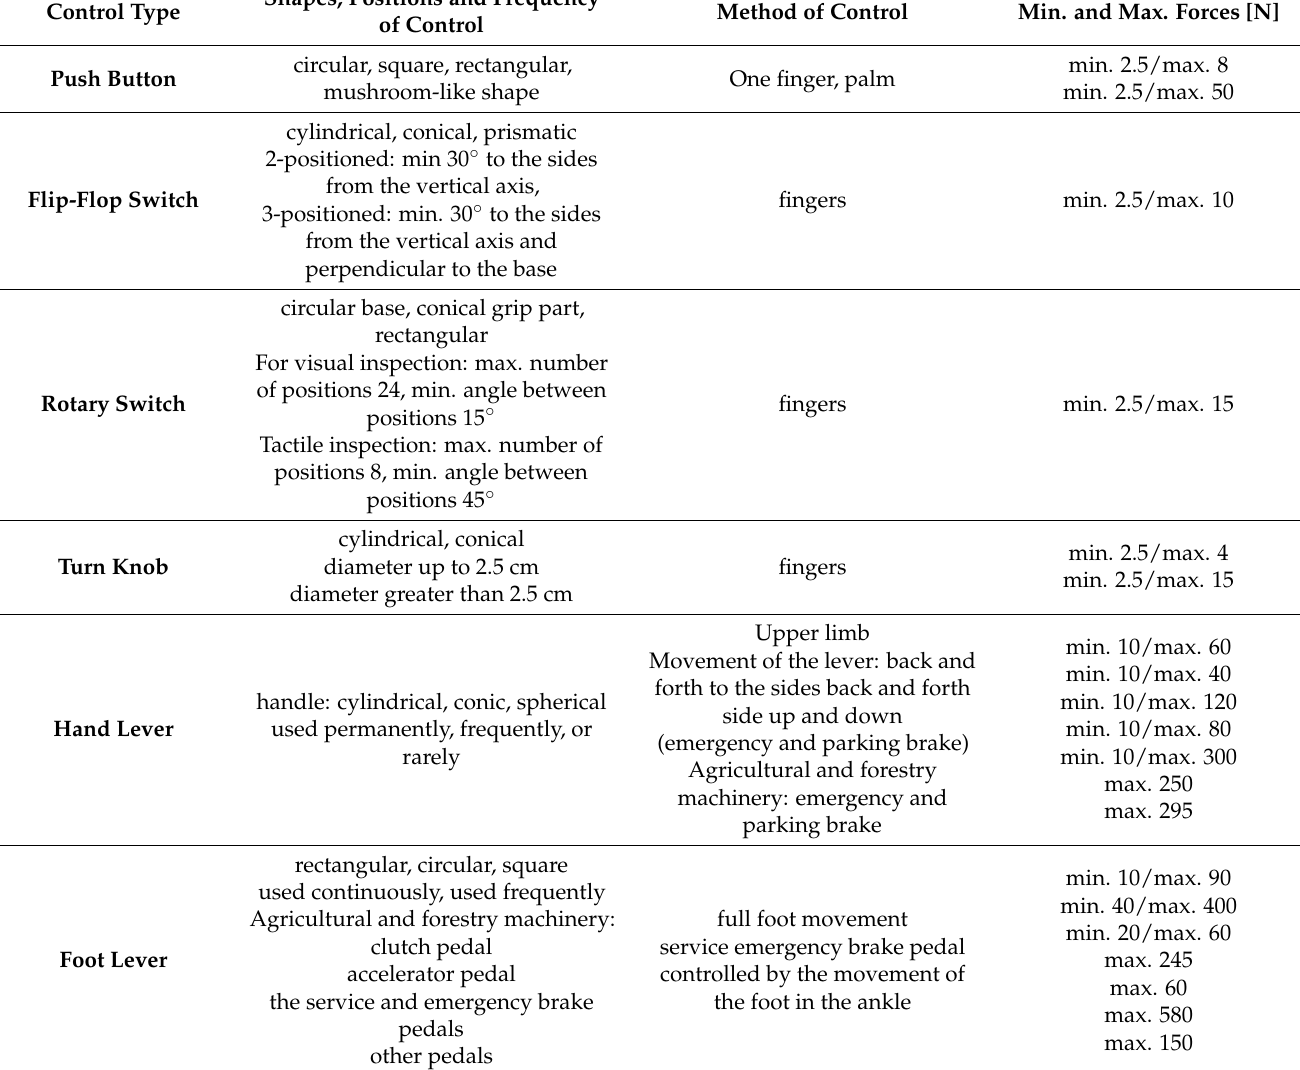
Table 1. Overview of controls-types, shapes, positions, method of control and control forces (Source: [32]). Control Type Method of